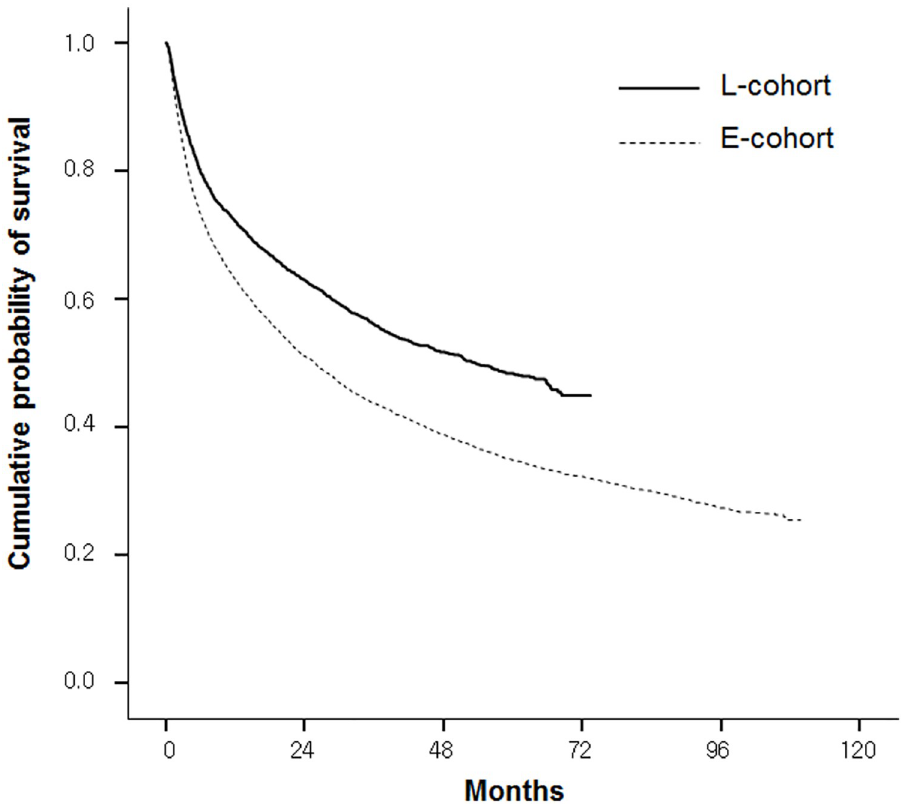
Fig 3. Kaplan-Meier analysis of overall survival between the E-Cohort and L-Cohort among patients with HBV- related HCC.